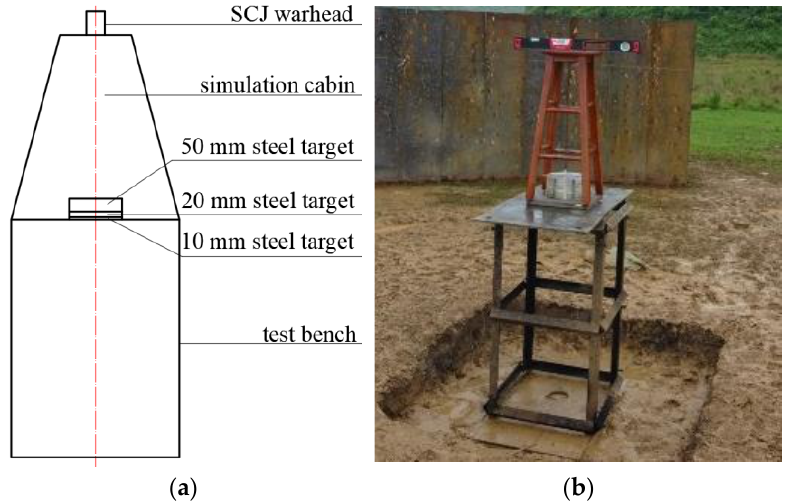
Figure 9. Penetration experiment setup without the simulation cabin: ( a ) schematic diagram of no cabin test setup, ( b ) no cabin test drawing.